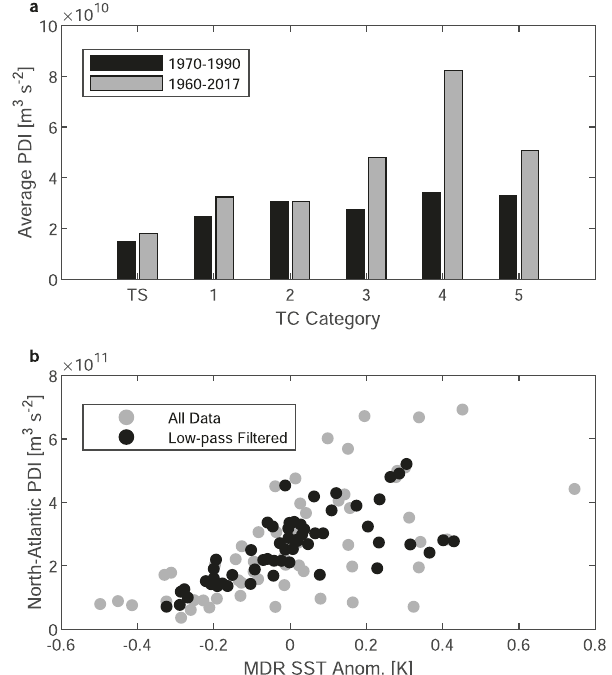
Fig. 1 | Power dissipation index and sea-surface temperature anomaly. a Average power dissipation index per year and per storm category for the period from 1970to 1990(blackbars) and from 1960 to 2017 (gray bars). b Scatterplot of powerdissipationindexagainstmaindevelopmentregionseasurfacetemperature anomaly (gray, R =0.63), and 7-year cutoff low-pass fi ltered power dissipation index against main development region sea surface temperature anomaly (black, R =0.68), from 1960 to